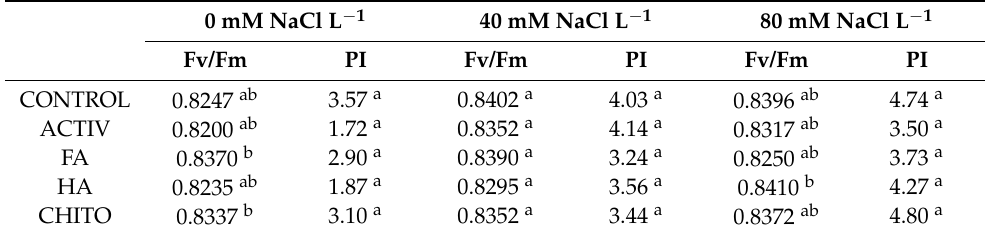
Table 9. Effect of biostimulants and salinity levels on the chlorophyll fluorescence parameters (variable fluorescence/maximum fluorescence (Fv/Fm) and performance index (PI)) of baby leaf lettuce plants under conventional